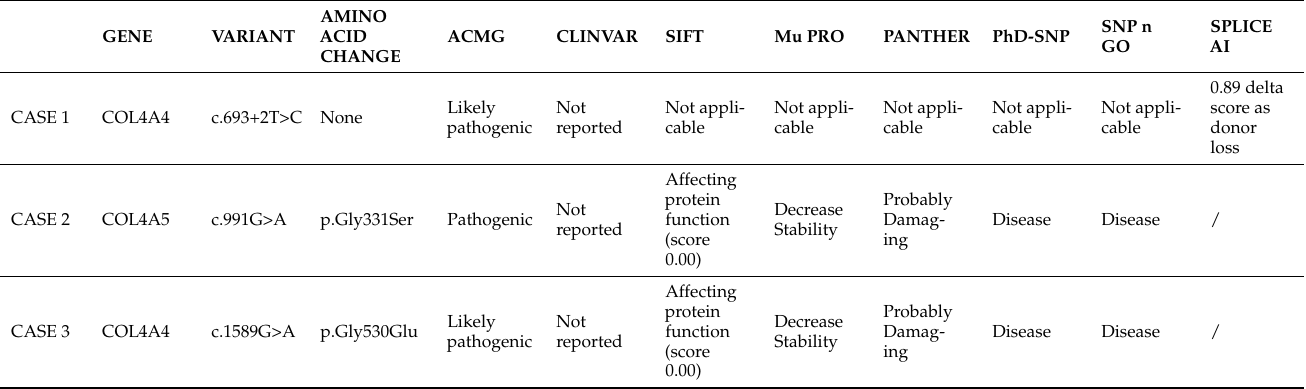
Table 3. Pathogenicity of variants. For all variants ACMG classification and ClinVar reports are